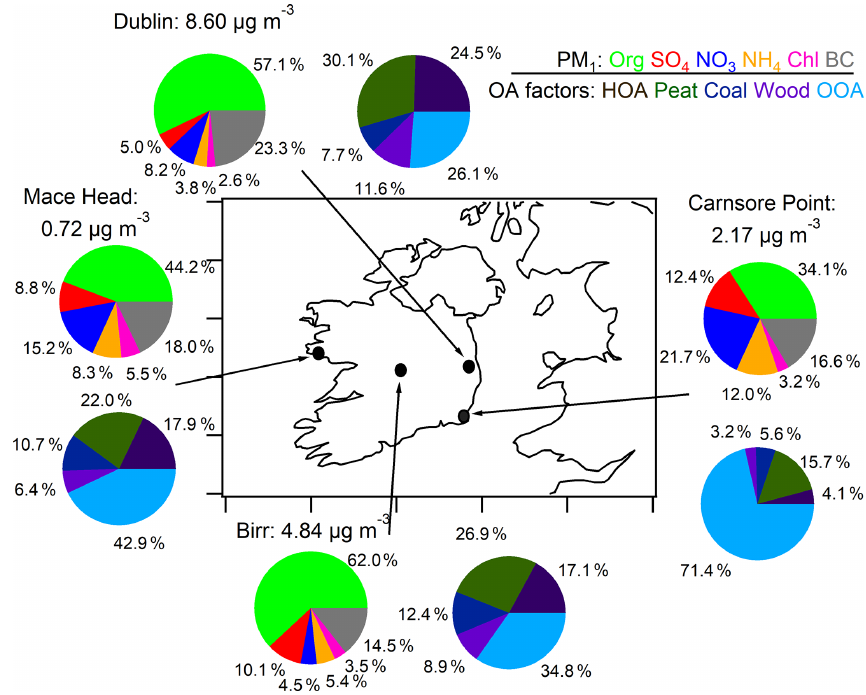
Figure 2. Average mass concentration and composition of PM 1 and the fractions of the OA factors in Dublin (top), Carnsore Point (right), Birr (bottom), and Mace Head